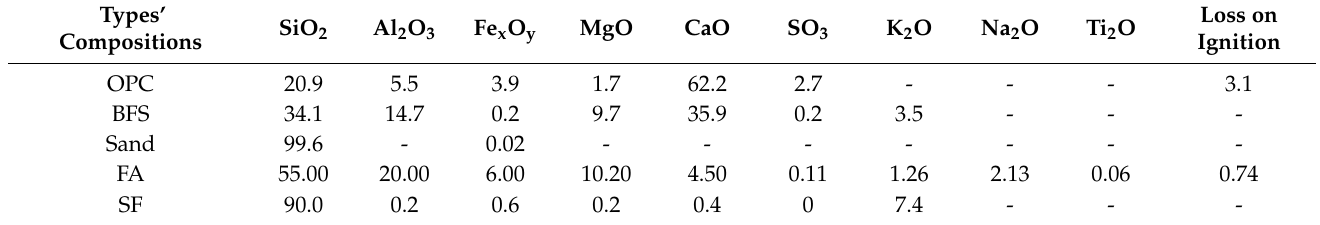
Table 2. The compositions (%).